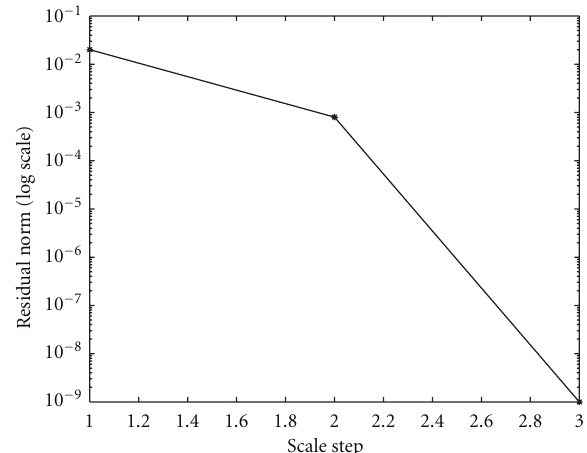
Table 4: Convergence history of Algorithm SI. Δ τ SI = 0 . 16. First